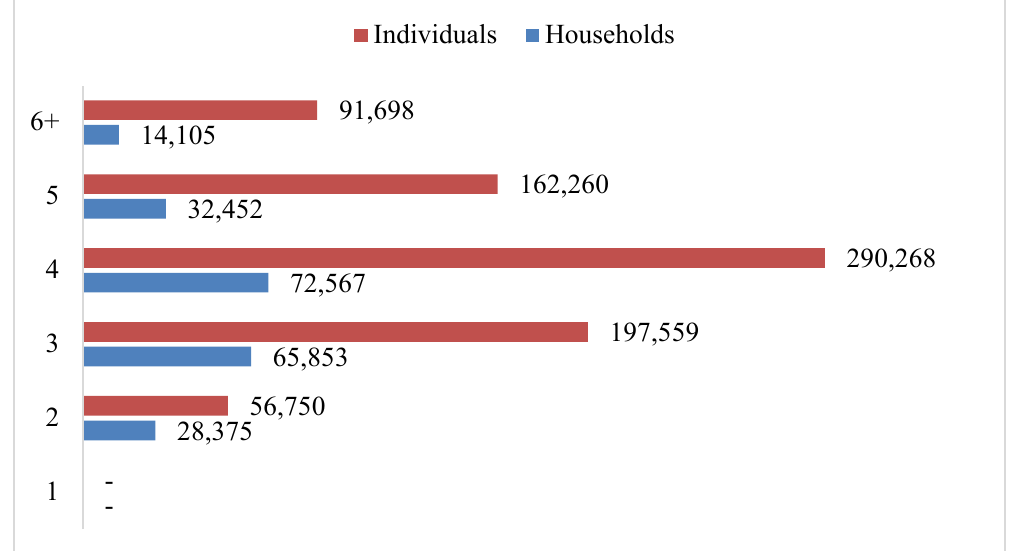
Figure 17. REM household recipients, by regions and Legislative Decree, 2021. Source: own elaboration on the INPS database.